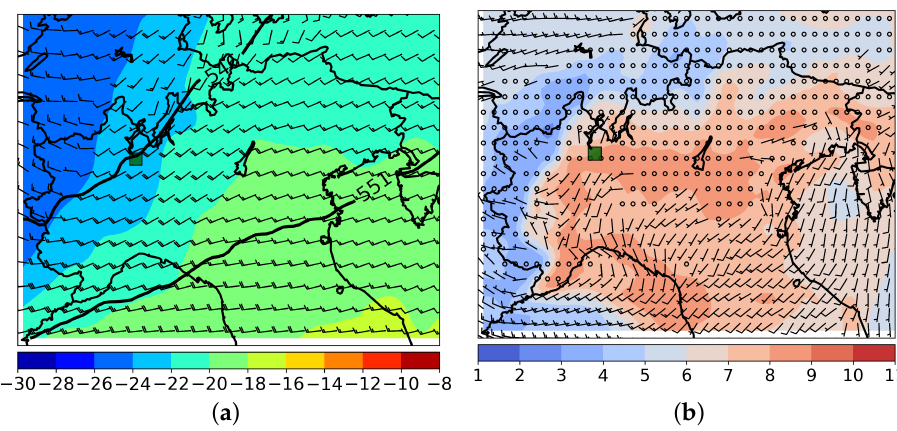
Figure 2. ECMWF-HRES forecast starting 11 May 12:00 UTC, at 15:00 UTC (analysis is not available): temperature ( ◦ C), wind (barbs) and geopotential height (dm, contours) at 500 hPa over northern Italy ( a ). Specific humidity (g kg − 1 ) and wind (barbs) at 950 hPa ( b ). The green square indicates the location of Malpensa airport.